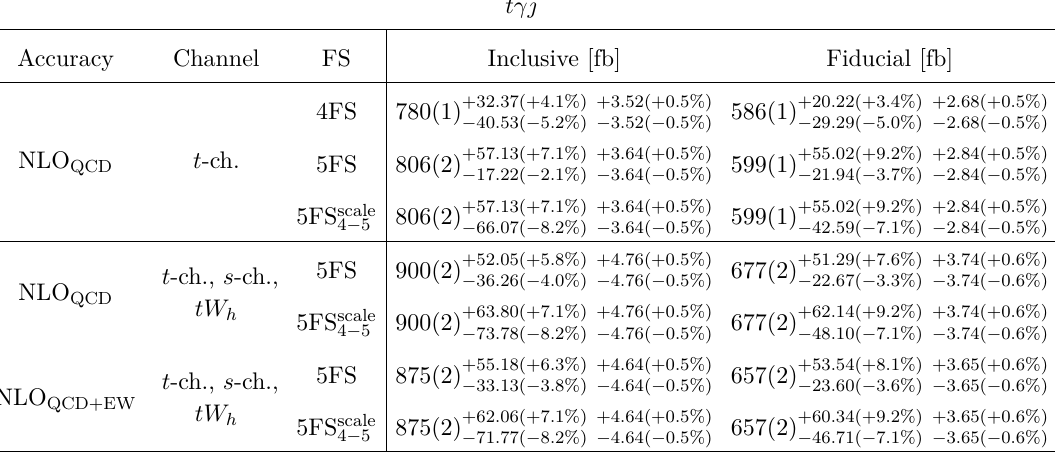
Table 4 . Cross section for tγj production. The uncertainties are respectively the (flavour+)scale and the PDF ones in the form: ± absolute size ( ± relative size). The first number in parentheses after the central value is the absolute statistical